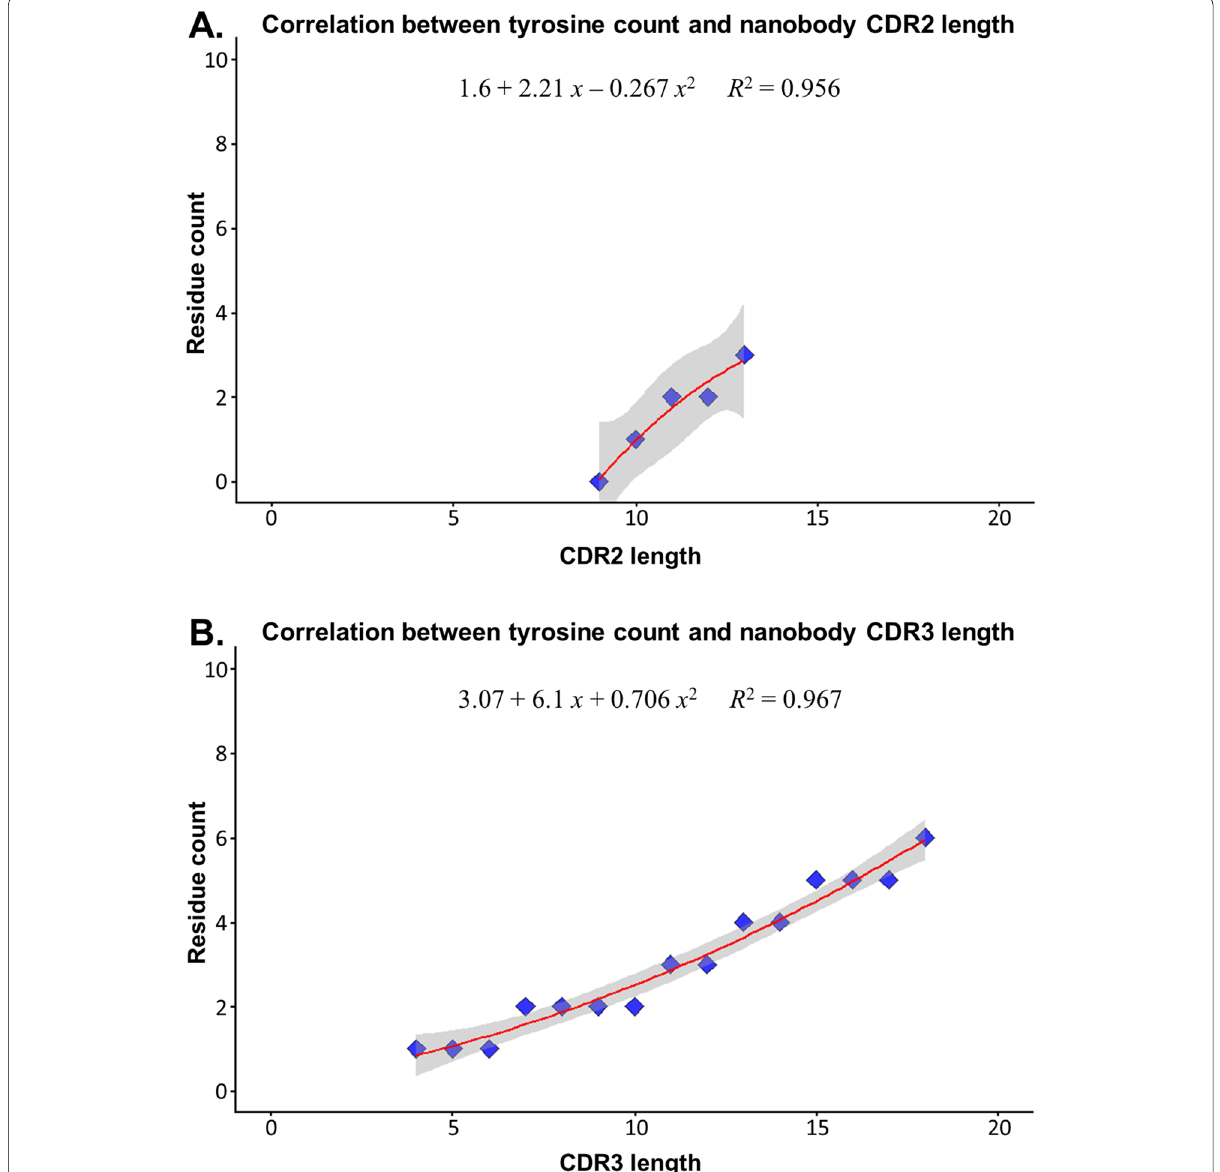
Fig. 4 Correlation between the highest occurrence of tyrosine and CDR lengths. A CDR2. B